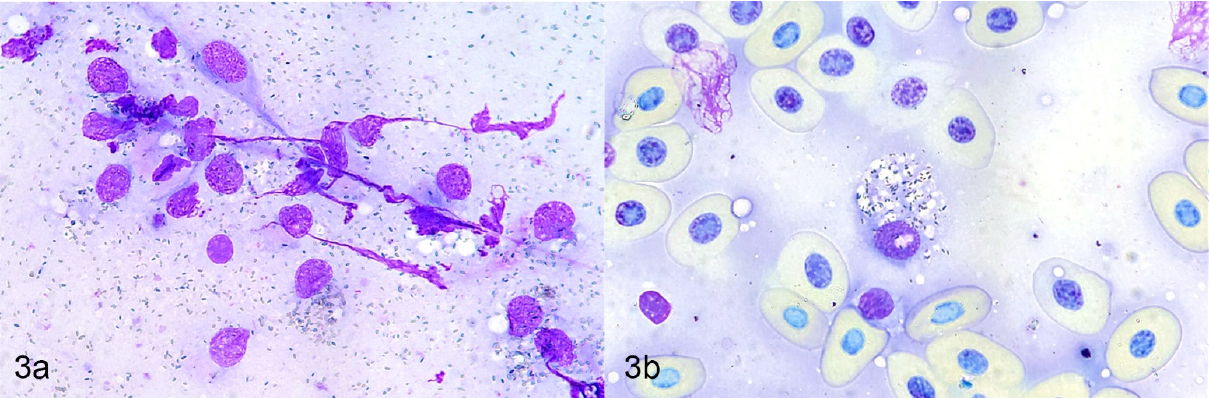
Figure 3. Cytologic aspirates of a chromatophoroma in a canebreak (timber) rattlesnake ( Crotalus horridus atricaudatus ). Romanowsky-type stain. ( a ) Few individualized spindloid cells with intracytoplasmic blue-black pigmented granules and numerous identical extracellular granules. ( b ) Round cell with numerous cytoplasmic pigment granules.